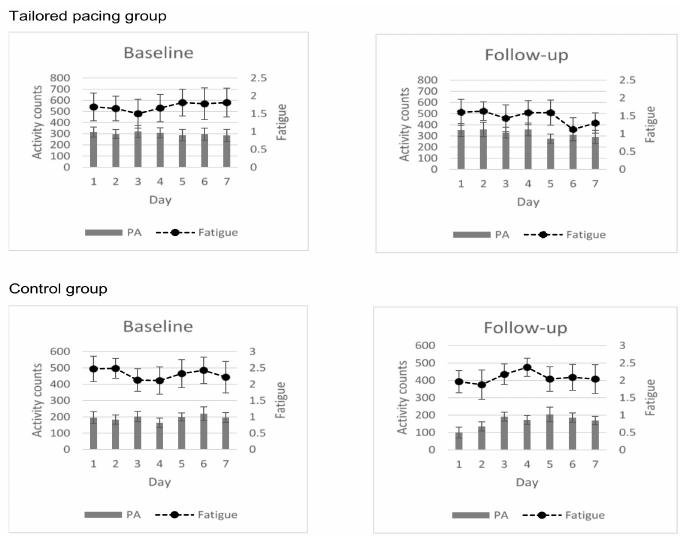
Figure 2. Changes in fatigue (dashed line) and activity levels; counts per minute (grey bar) between baseline and follow-up over a 7-day